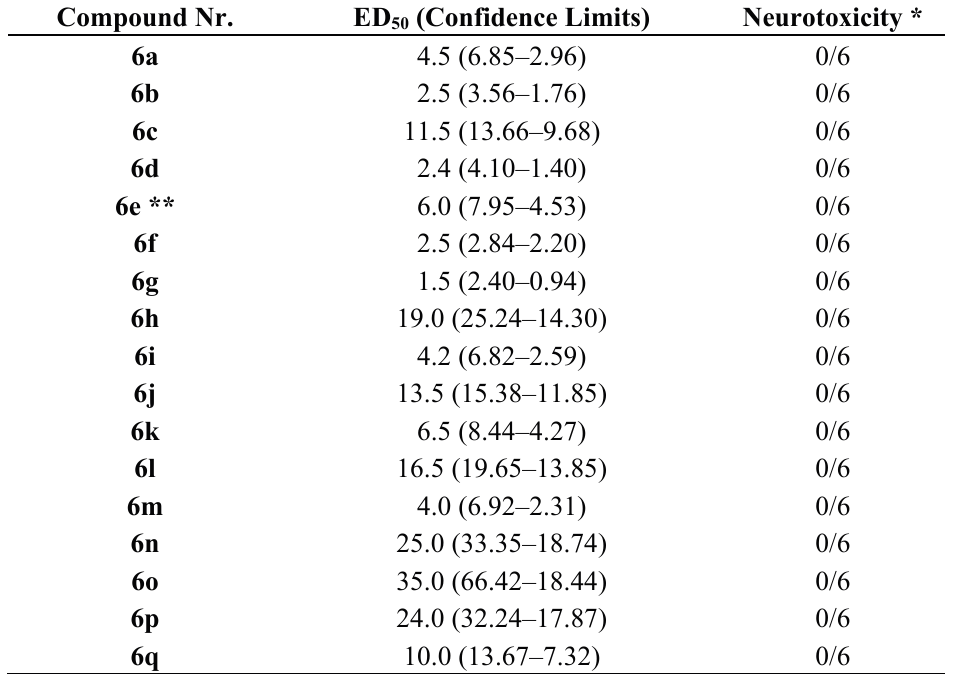
Table 2. Median effective dose (ED 50 , mg/kg) of compounds 6a – t and 6v – x exhibiting 100% protection against scPTZ-induced seizers and their neurotoxicity in adult male albino mice using Phenobarbital and Ethosuximide as reference standards. Compound